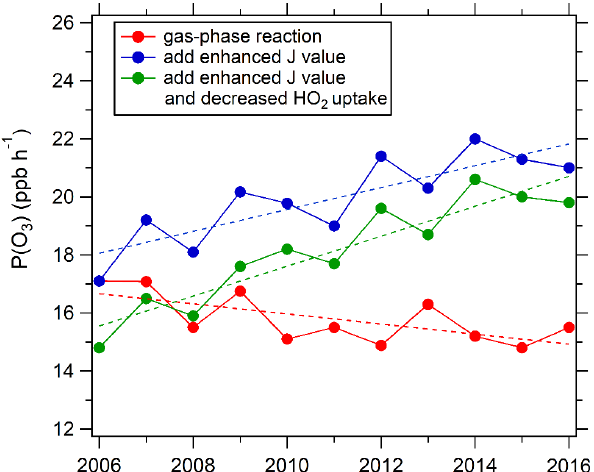
Figure 11. Trend of monthly daytime mean P ( O 3 ) simulated by the chemical box model. Red dots: only the gas-phase reactions are considered in the box model constrained by observed photolysis frequencies from 2006 for all 11 years. Blue dots: the box model as above, but constrained by the photolysis frequencies derived for each year. Green dots: the box model constrained by the photolysis frequencies derived for each year with the changing aerosol uptake of HO 2 also